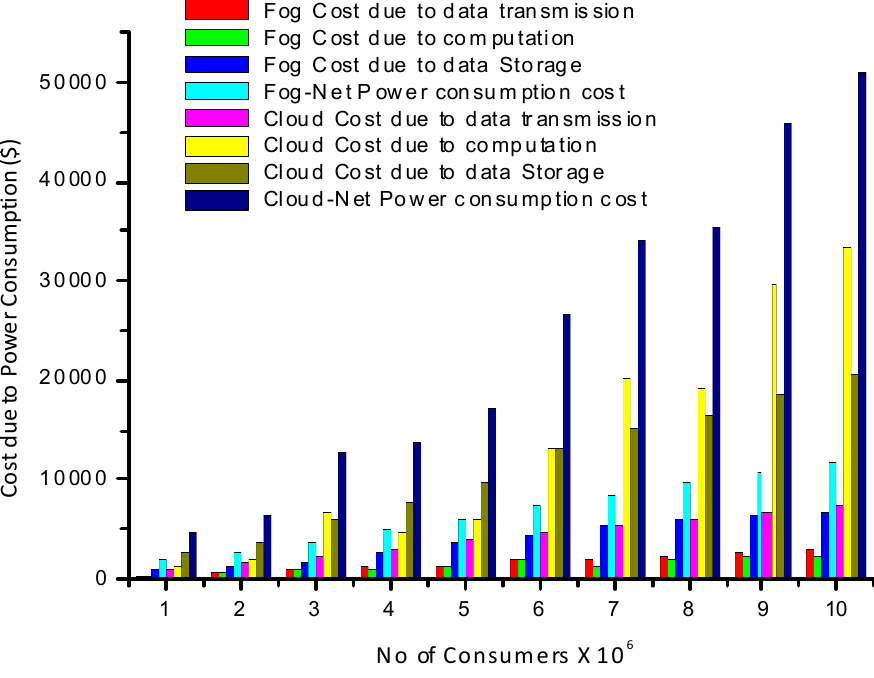
Figure 7. Comparison of various cost parameters involved in fog and generic cloud computing.